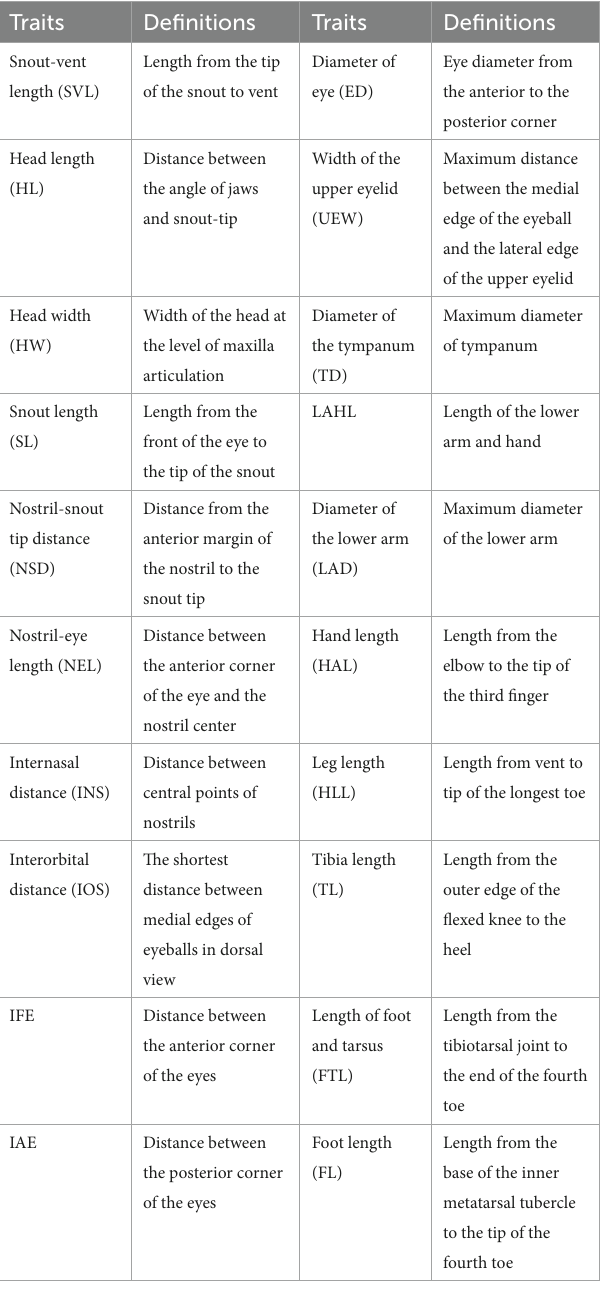
TABLE 2 Definitions of 20 morphological